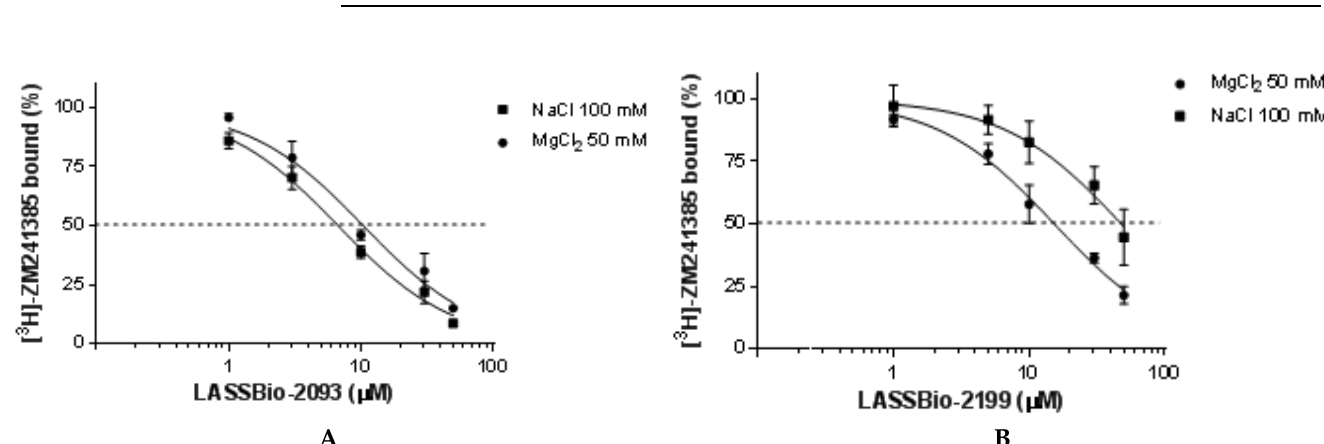
Figure 4. Na + -shift assay for the estimation of the intrinsic efficacy of the NAH derivatives 5 and 8 at the A 2A receptor (A 2A R) in rat striatum membrane preparation. Competition curves were performed using the antagonist radioligand (0.5 nM [ 3 H]-ZM241385) in the presence of 50 mM MgCl 2 or 100 mM NaCl. Each curve represents the averaged curve (±S.E.) from three independent paired experiments (in triplicate). ( A ) LASSBio-2093 ( 5 ); ( B ) N -methylated LASSBio-2199 ( 8 ).